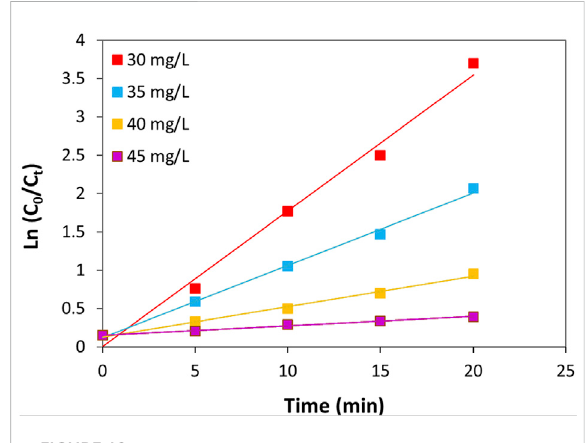
Co 3 O 4 , while the degradation ef fi ciencies were calculated to be 40% and 73% for NiFe 2 O 4 and ZnO/NiFe 2 O 4 , respectively (Figure 10A). The obtained reaction rate for TC